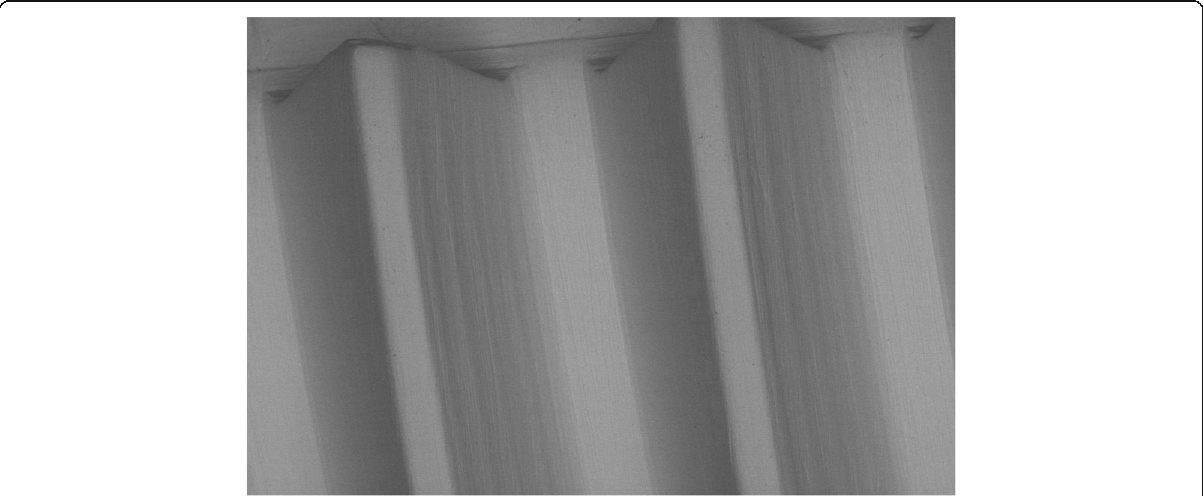
Fig. 3 Scanning electron microscopy picture of group C implant